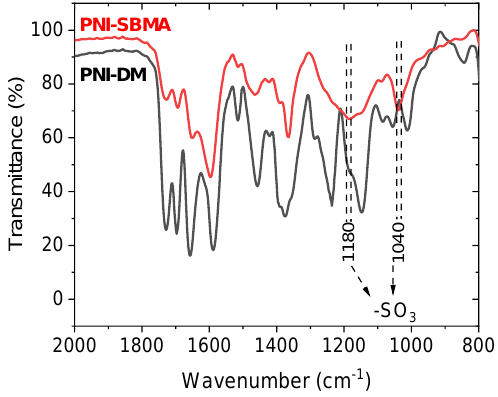
Figure 1. Fourier transform infrared (FTIR) spectrum of the PNI-DM and PNI-SBMA.